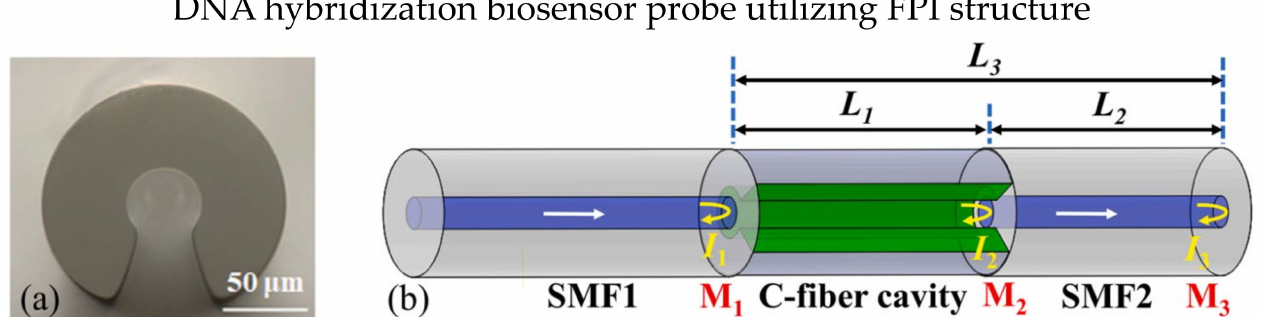
Figure 13. ( a ) Cross-section microscopic image of C-type fiber; ( b ) Schematic design of the biosensor, both ends of the C-type fiber are spliced with SMF and the C-type fiber serves as micro cavity. Reprinted with permission from Ref. [108]. Copyright 2022,